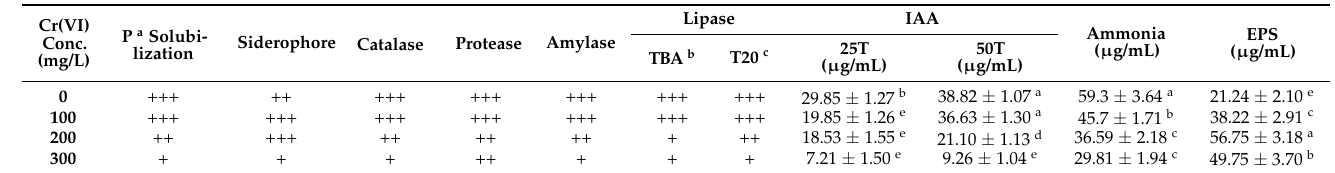
Table 3. Plant growth-promoting activities of the rhizobacterial strain M2 with the presence and absence of